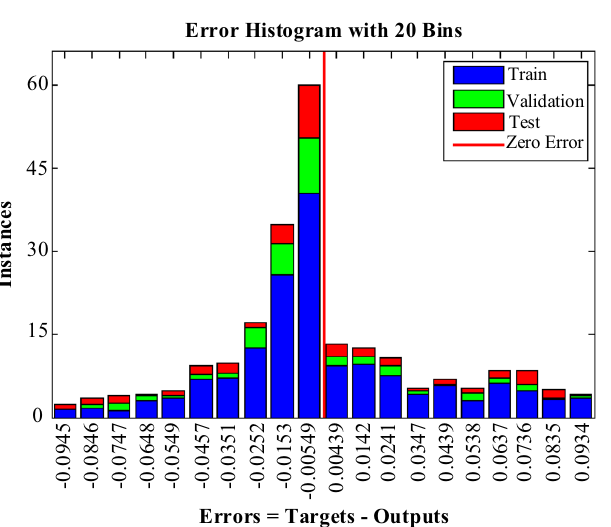
Figure 25. Error histogram diagram of the